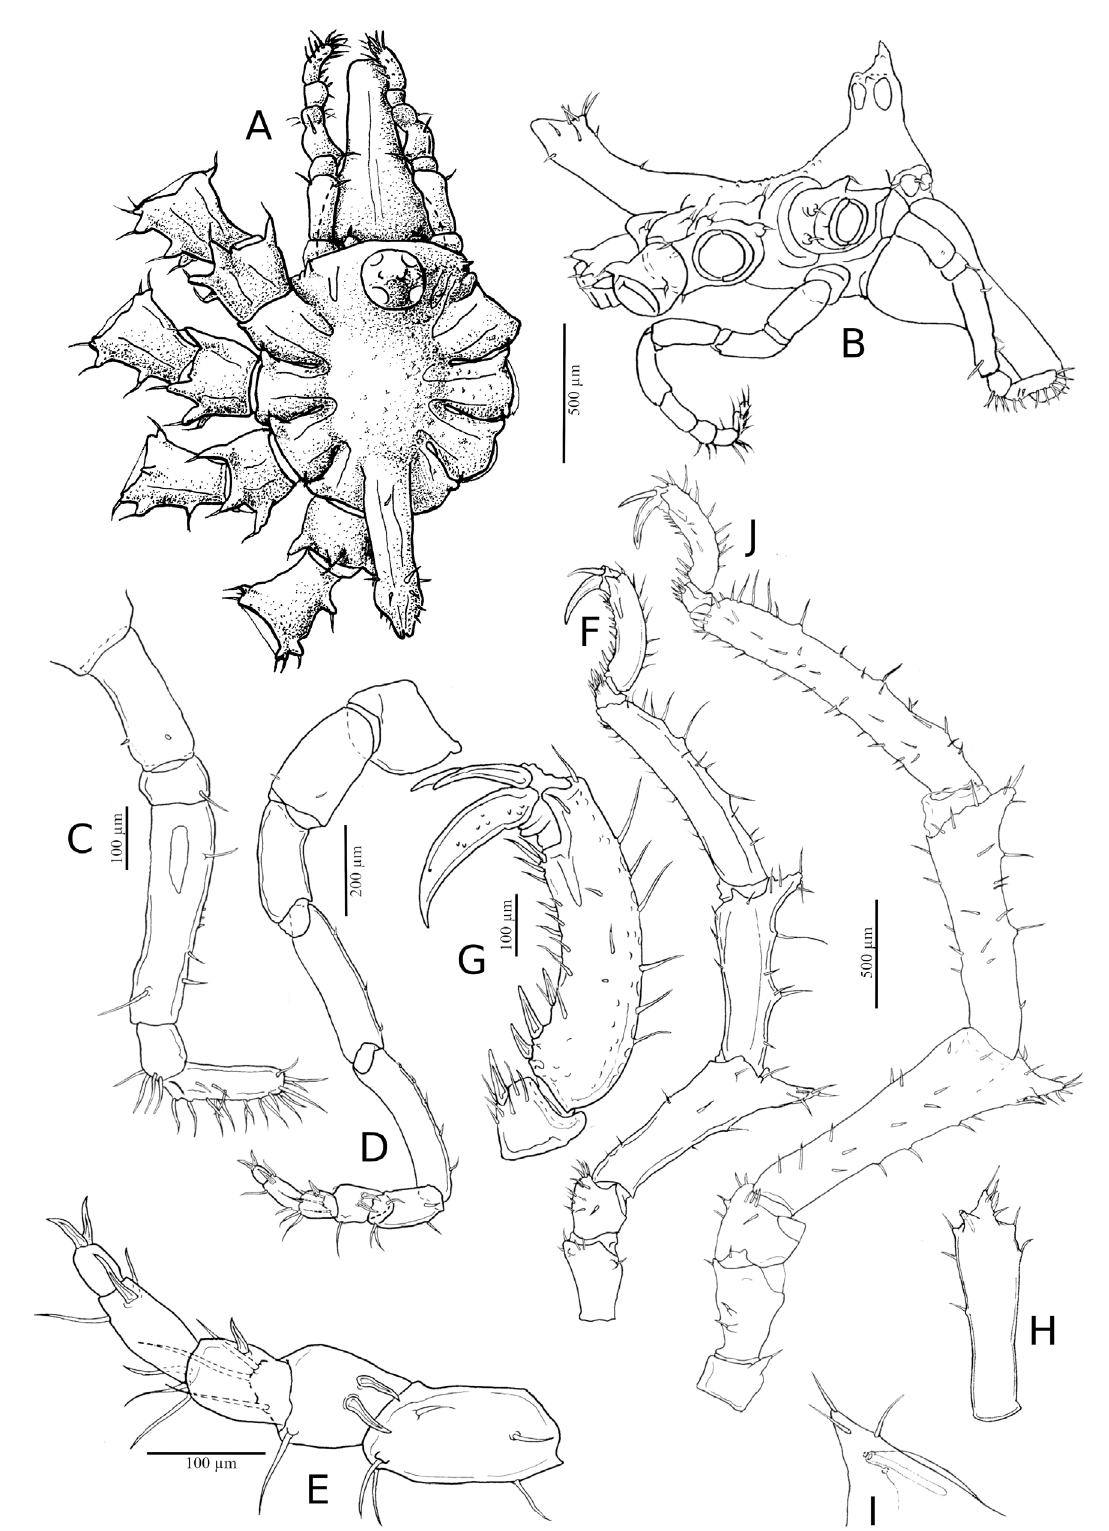
Fig. 6. Tanystylum ingrallis sp. nov., holotype, ♂, MNHN-IU-2016-1055. A . Body, dorsal view. B . Body, lateral view (same scale as A). C . Palp. D . Oviger. E . Oviger strigilis. F . Second leg. G . Tarsus and propodus of second leg. H . Femur of third leg, dorsal view (same scale as F). I . Close-up of distal spur on femur of second leg, and cement gland tube. J . First leg (same scale as